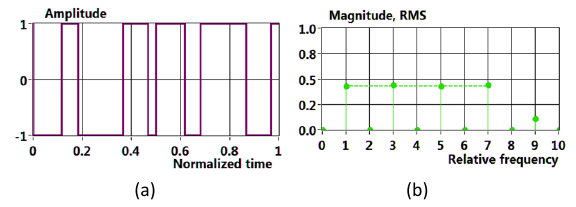
Fig.10: BMS waveform (a) and its magnitude spectrum (b) with four equally emphasized components (frequency bins 1, 3, 5, 7).